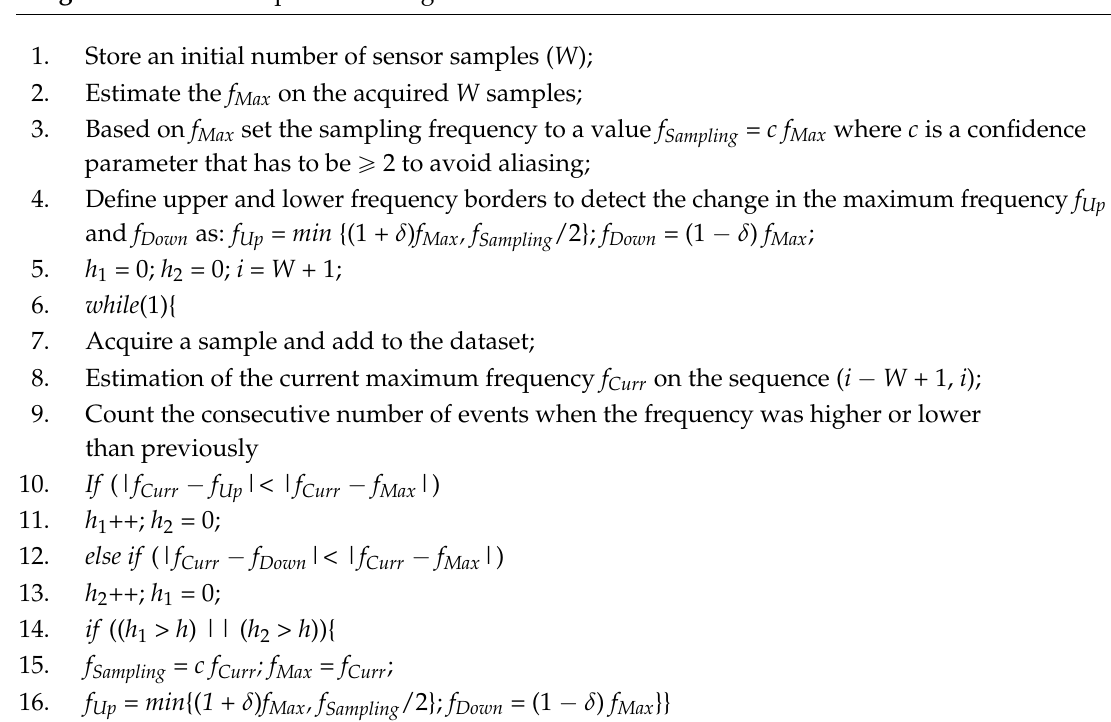
Algorithm 1 An example of ASA